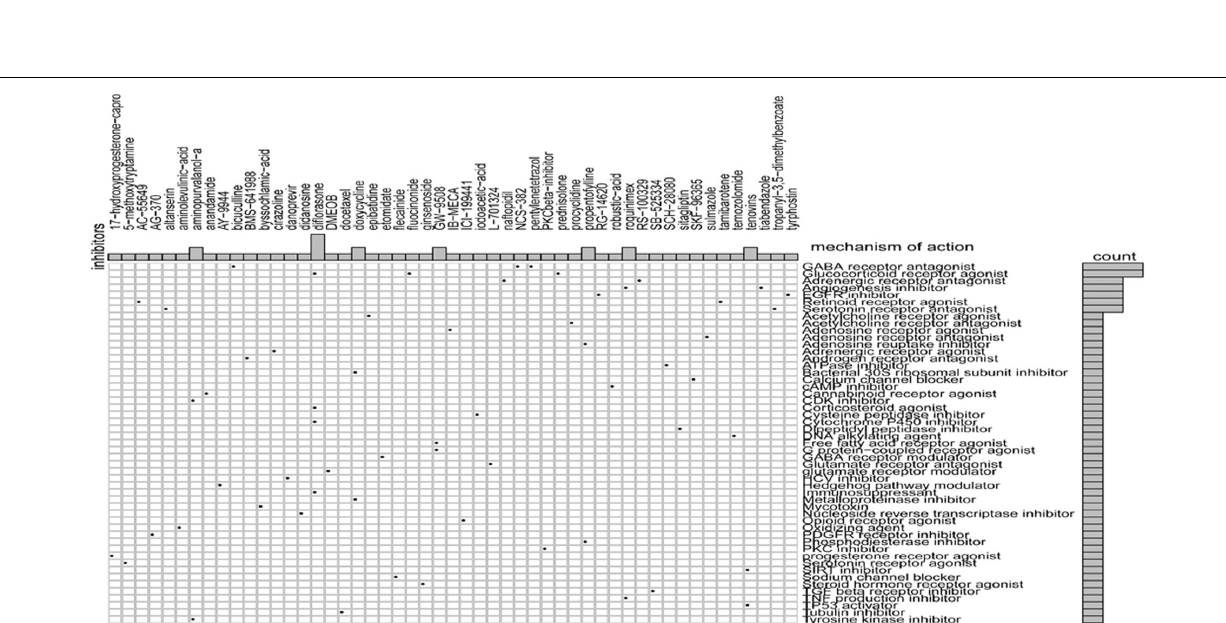
Frontiers in Cell and Developmental Biology |